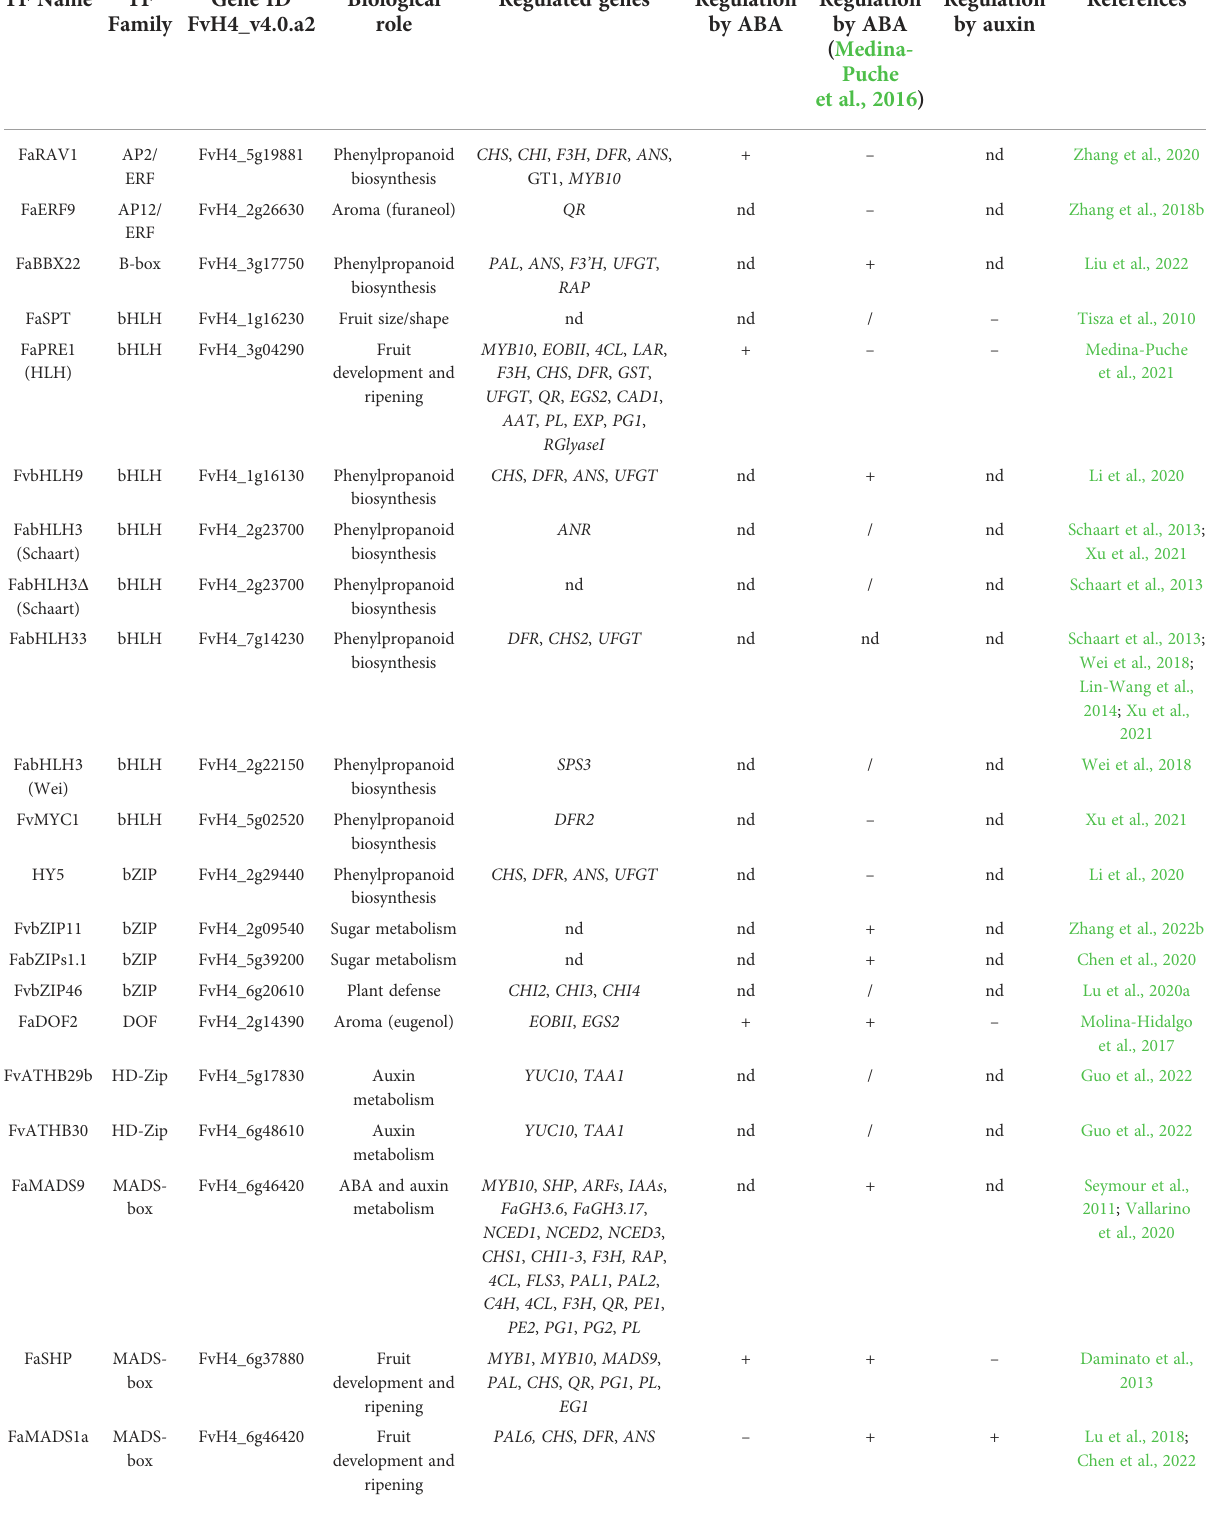
TABLE 1 List of strawberry fruit development- and ripening-related transcription factors and their biological